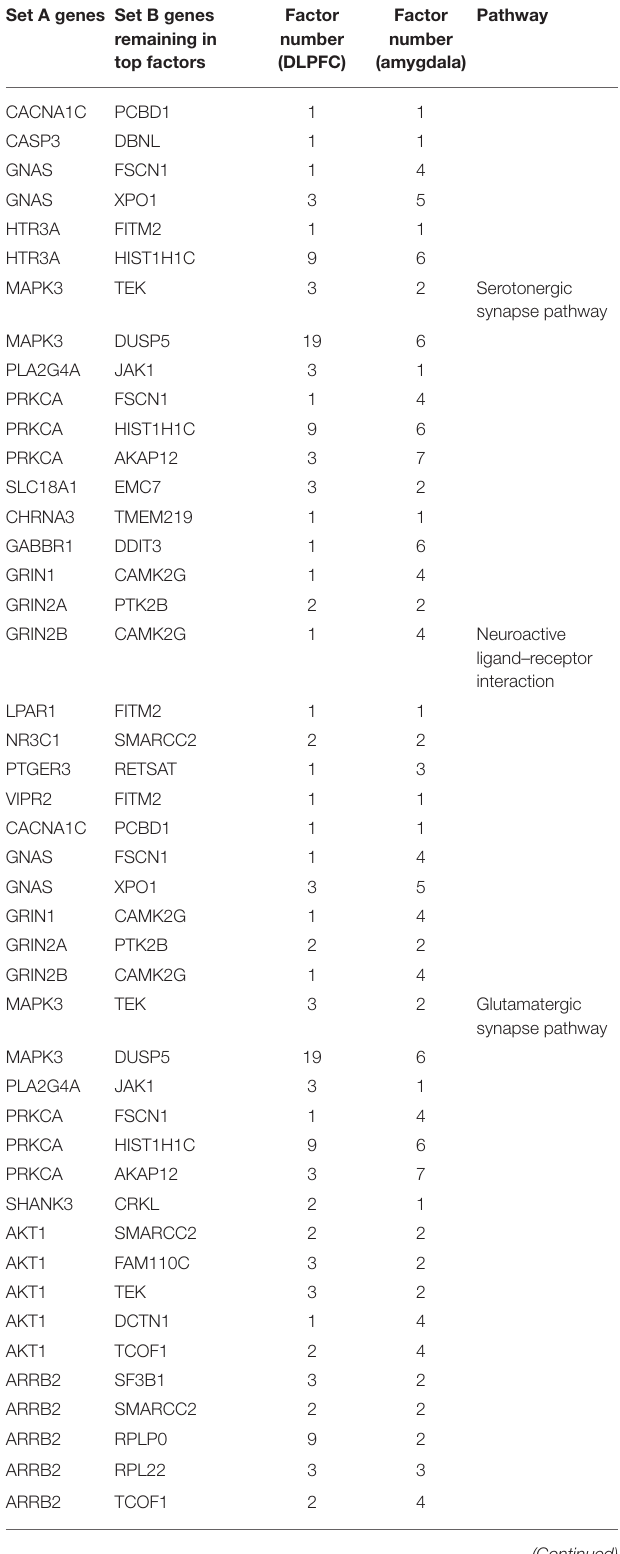
TABLE 2 | Interactions in both dorsolateral prefrontal cortex (DLPFC) and amygdala from expanding schizophrenia-associated networks. Set A genes Set B genes remaining